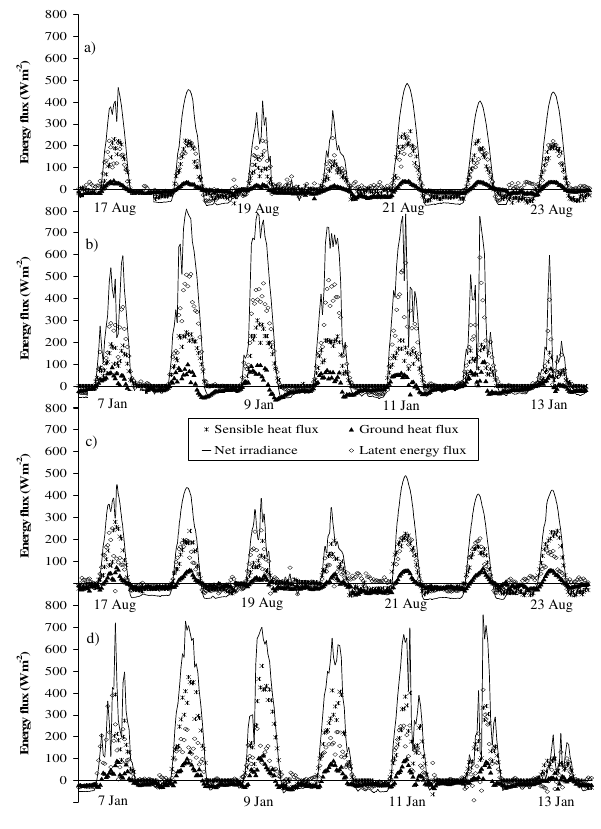
Fig. 5. Diurnal energy fluxes at Mfabeni Mire on (a) 17 to 23 Au- gust 2009 and (b) 7 to 13 January 2010 and on corresponding days at the Embomveni Dunes in (c) August 2009 and (d) January